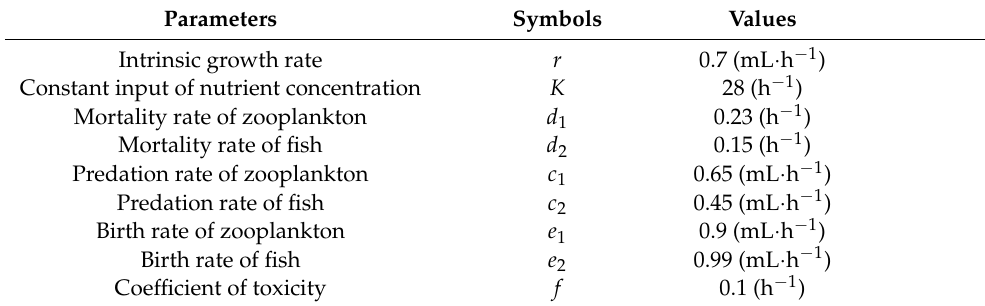
Table 2. Parameter values used in the numerical simulation (Plankton–Zooplankton–Fish Interac- tion